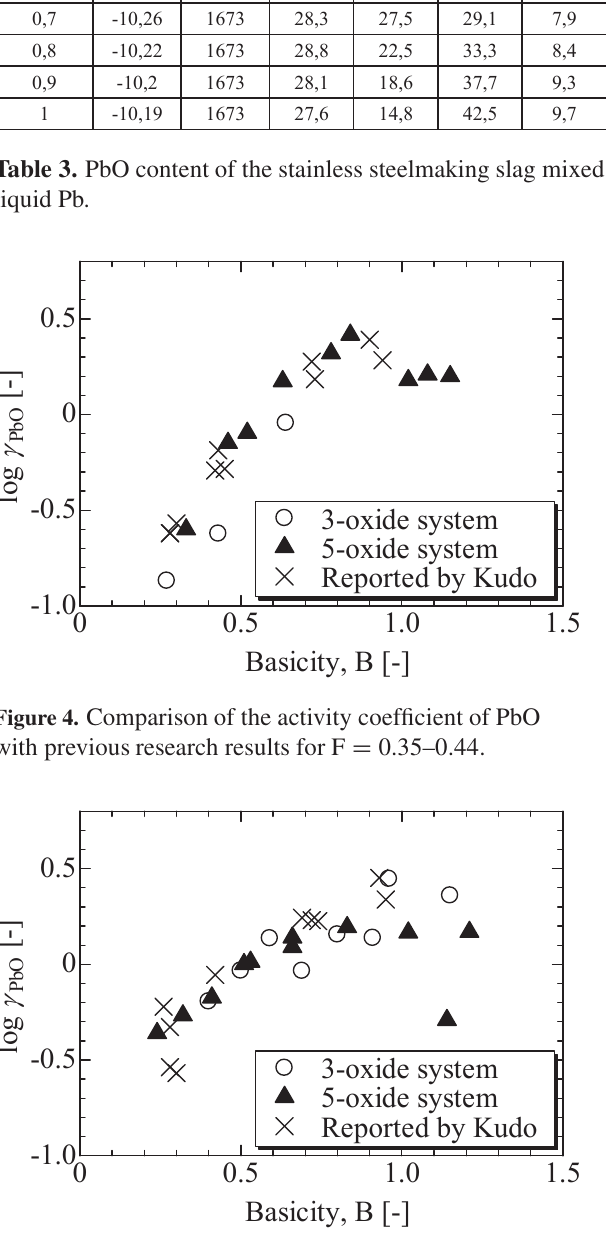
Figure 5. Comparison of the activity coefficient of PbO with previous research results for F D